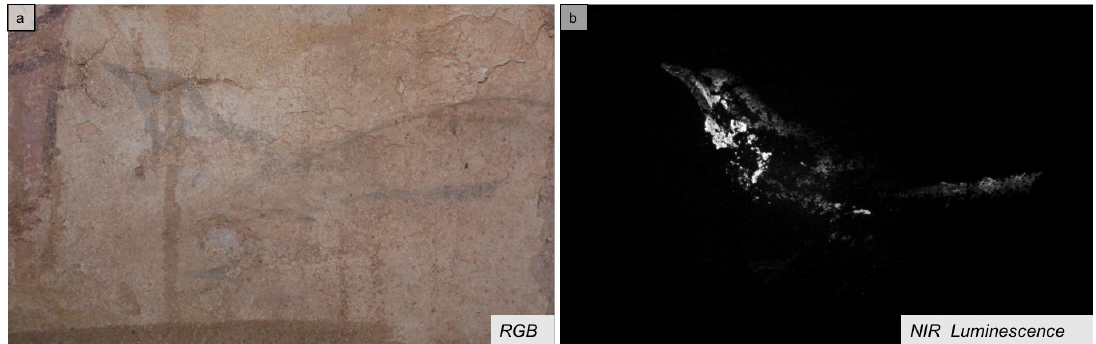
Figure 25. ( a ) A color (RGB) image of a small, faded grey-blue bird on the dado of the central arcosolium (J); ( b ) The near-infrared luminescence image identifies Egyptian blue as one of the major pigment constituents for the hue and recovers the figure of the damaged